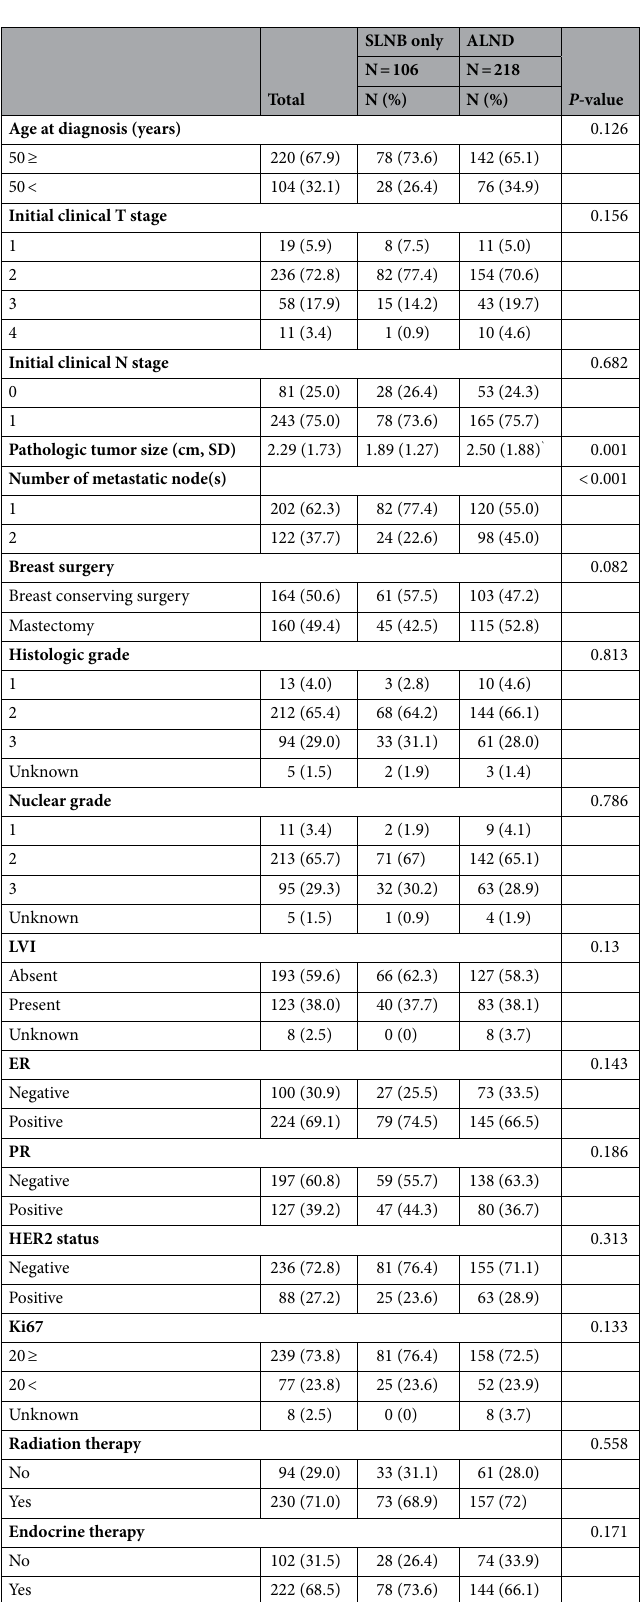
Table 1. Baseline patient characteristics before matching. SLNB, sentinel lymph node biopsy; ALND, axillary lymph node dissection; SD, standard deviation; LVI, lymphovascular invasion; ER, estrogen receptor; PR, progesterone receptor; HER2, human epidermal growth factor receptor type